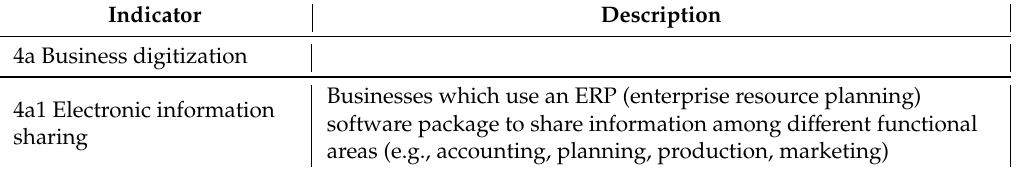
Table 4. A Dimension of Digital Technology Integration in the DESI structure